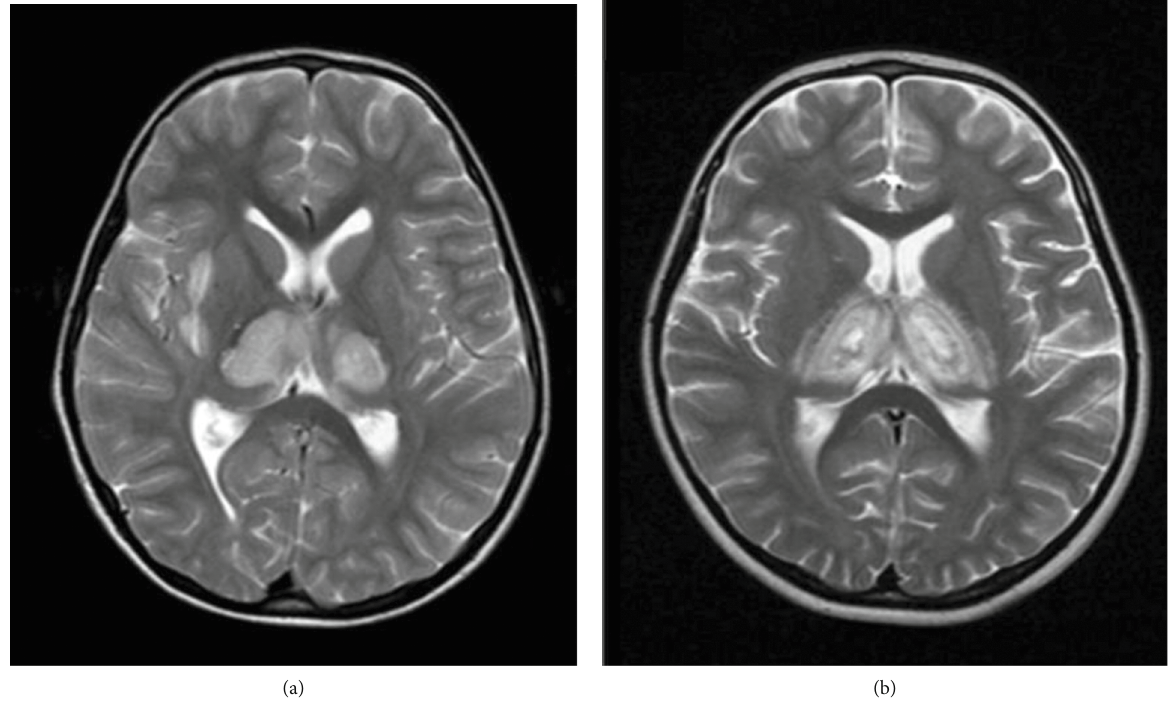
Figure 2: MRI images of case 2 (a) and case 3